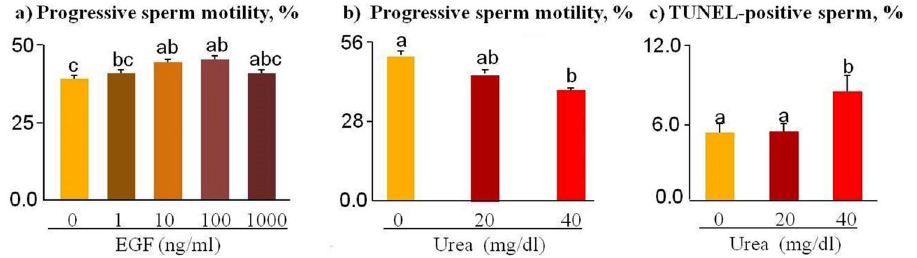
Figure 1. Determination of the effective dose of EGF and urea. Sperm cells were incubated for 30 min with different doses of EGF (0, 1, 10, 100, and 1000 ng/ml) and urea (0, 20, and 40 mg/dl), followed by progressive sperm motility (CASA) and DNA fragmentation (TUNEL test, n = 5) studies. The data was analyzed using the Tukey test. Numerical values are shown as mean ± SEM. Different letters (a, b, c) indicate significant differences between treatments at P <